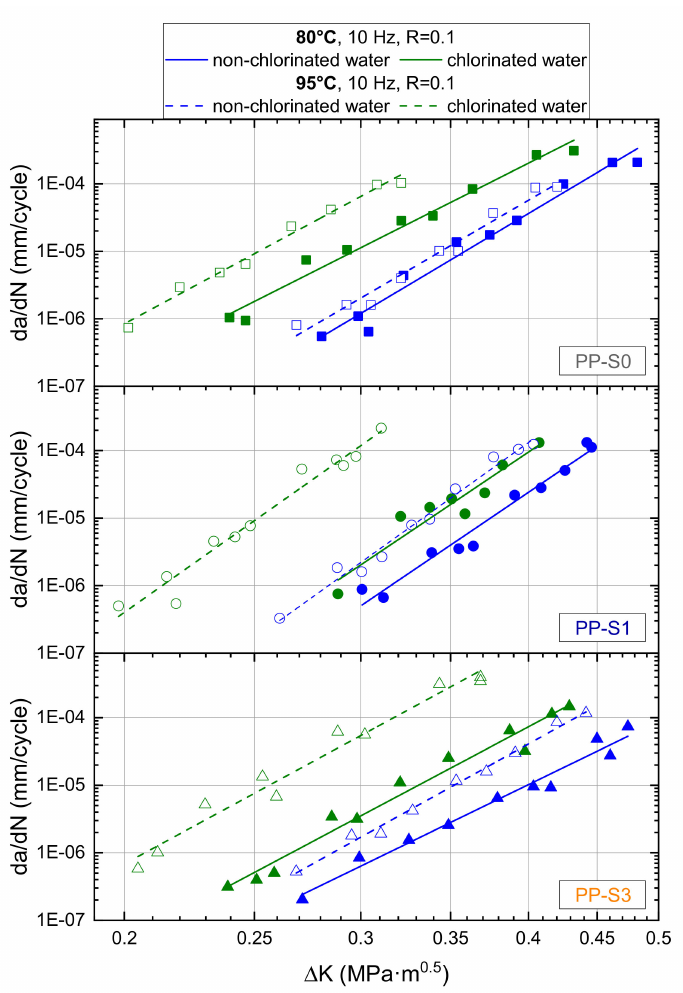
Figure 5. Fatigue crack growth (FCG) curves of PP-S0, PP-S1, and PP-S3 tested at 80 ◦ C and at 95 ◦ C in non-chlorinated water (0 mg / L free chlorine) and in chlorinated water (5 mg / L free